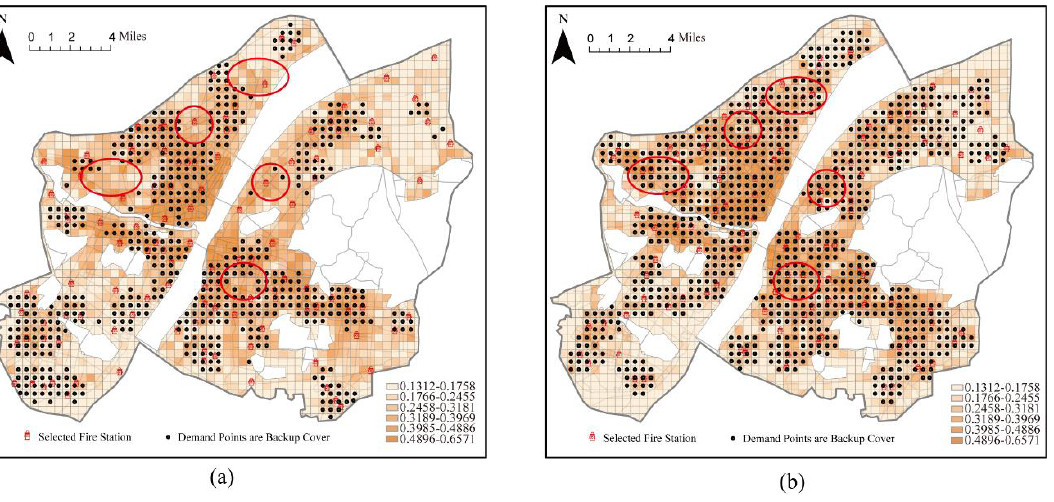
Figure 13. Coverage under different models. ( a ) Maximal coverage model; ( b ) backup coverage model.